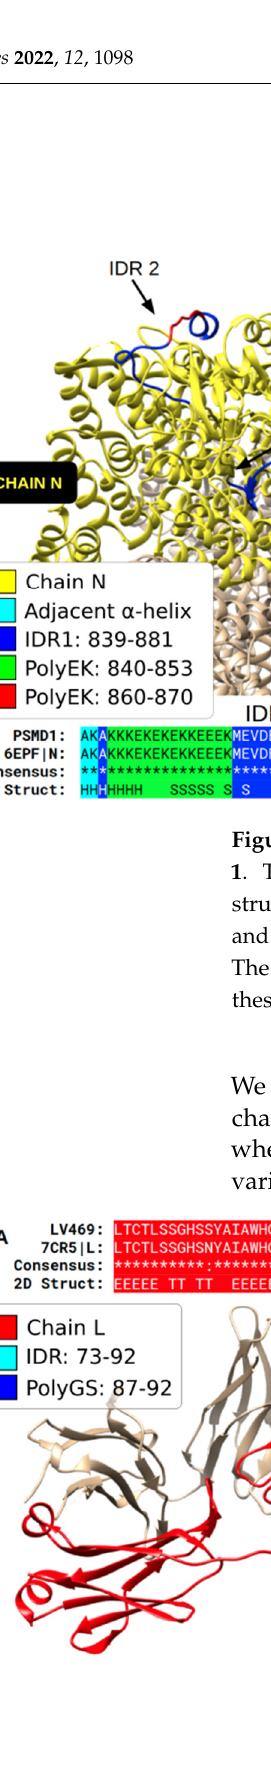
Figure 7. Structures of immunoglobulin light chains show β structure in predicted IDRs with polyGS . ( A ) Structure of a human monoclonal antibody (PDB:7CR5 chain L) with a sequence almost identical to protein LV469 Immunoglobulin lambda variable 4–69 (UniProt: A0A075B6H9), a V region of variable domain of immunoglobulin light chains. The polyGS composes one of the strands from one of the four β -sheets of this immunoglobin structure. ( B ) Structure of a human antibody (6Q0E chain L) identical to human protein LV319 Immunoglobulin lambda variable 3–19 (UniProt: P01714). Pipe signs at the end of the alignment indicate that the chain ended at this position.